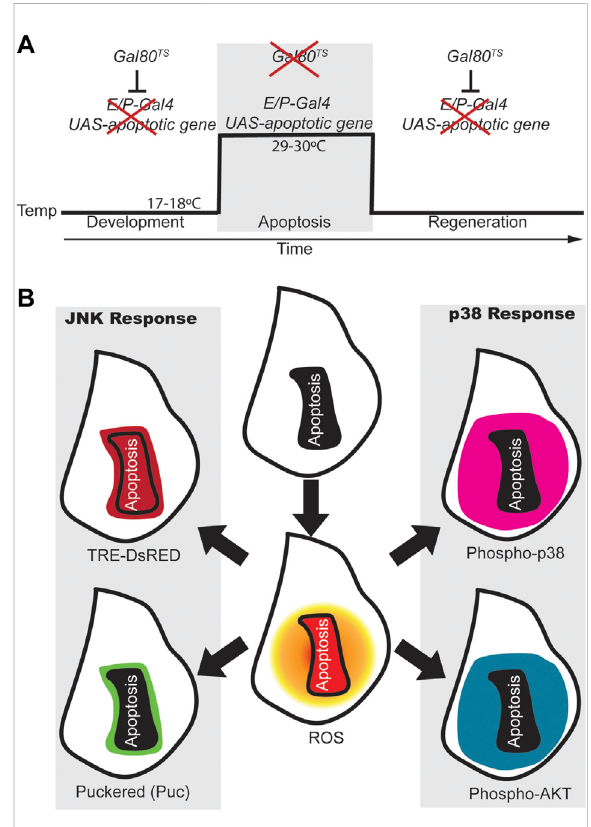
FIGURE 1 ROS-dependent responses in early regeneration. (A) Design for genetic induction of cell death (genetic ablation). Drosophila strains carrying tissue speci fi c (enhancer/promoter) expression of Gal4 ( E/P-Gal4 ) will allow the transcription of the pro- apoptotic gene cloned downstream of the UAS sequence when Gal80 is inhibited (at 29 – 30 ° C). However, at 18 ° C the temperature sensitive Gal80 is active and blocks Gal4 which results in regeneration of the apoptotic tissue. (B) Scheme of wing imaginal discs showing the activity of some of the early responding signals after apoptosis. After genetic ablation, apoptotic cells produce high levels of ROS (Red in the central disc), which spreads to cells surrounding the apoptotic domain (shaded orange circle); Apoptotic cells and few non-apoptotic cells nearby, show expression of the JNK reporter TRE-DsRed (dark red). The puckered phosphatase ( puc in green) is transcribed downstream JNK mainly in cells that are nearby the apoptotic zone. P-Akt and P-p38respondinabroaderdomainandbothfoundinsurrounding the dead domain. Apoptotic cells are outlined with a black line in the center of each disc or with a solid black